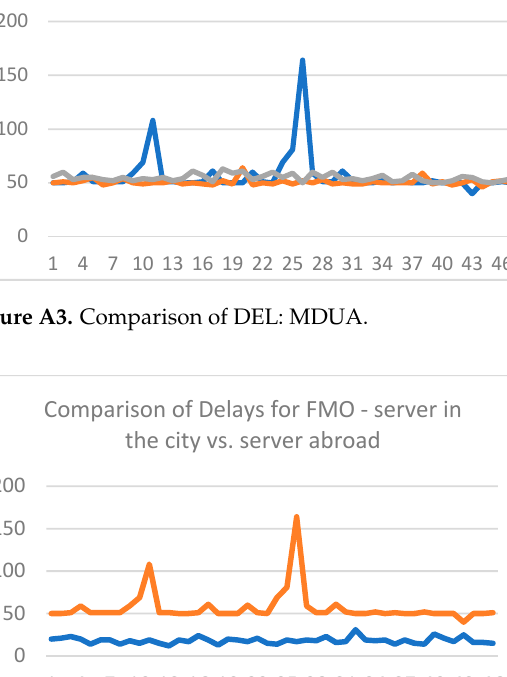
Figure A4. Comparison of delay patterns: server in the city vs. server located abroad.